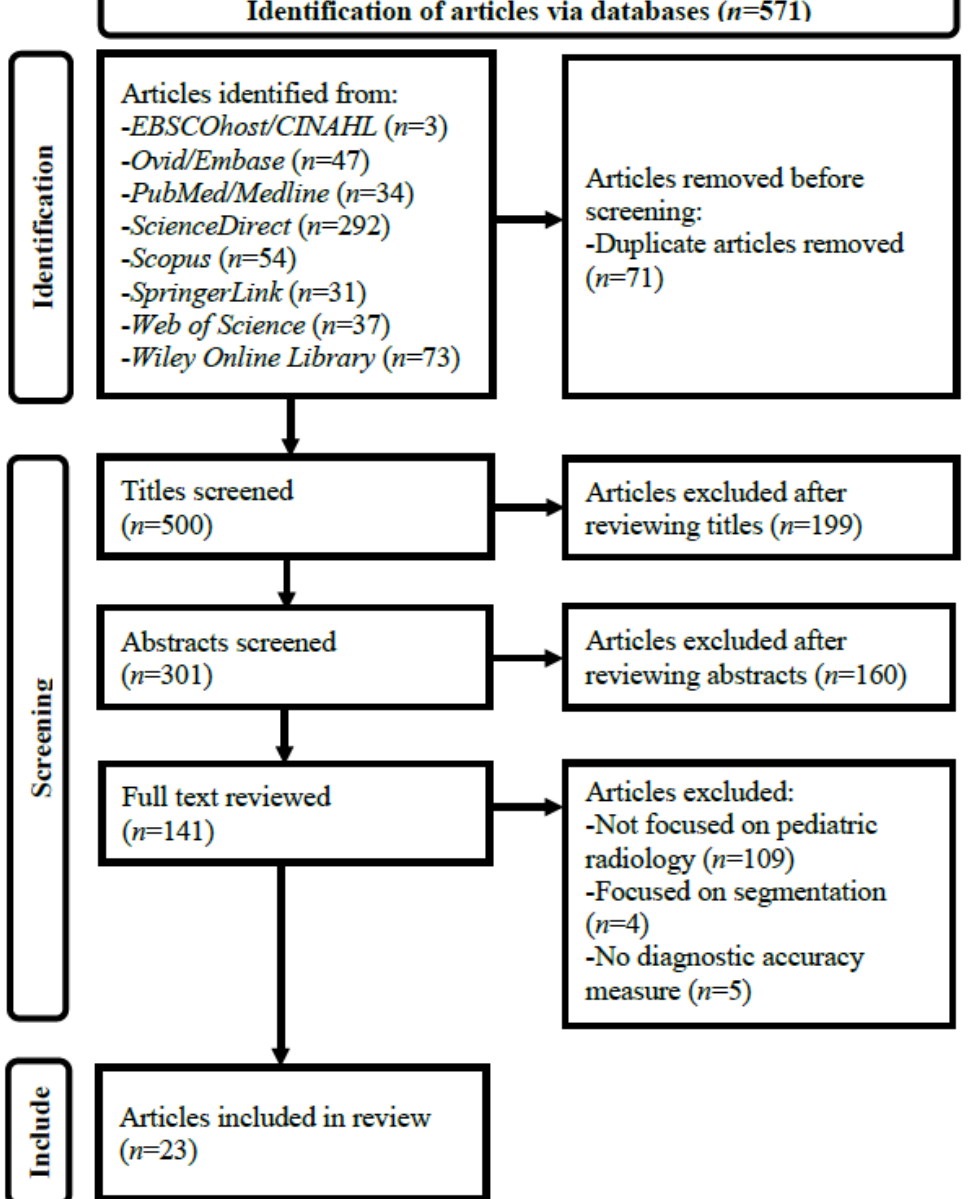
Figure 1. Preferred reporting items for systematic reviews and meta-analyses flow diagram for sys- tematic review of diagnostic performance of artificial intelligence-based computer-aided detection and diagnosis in pediatric radiology. CINAHL, Cumulative Index of Nursing and Allied Health Literature.